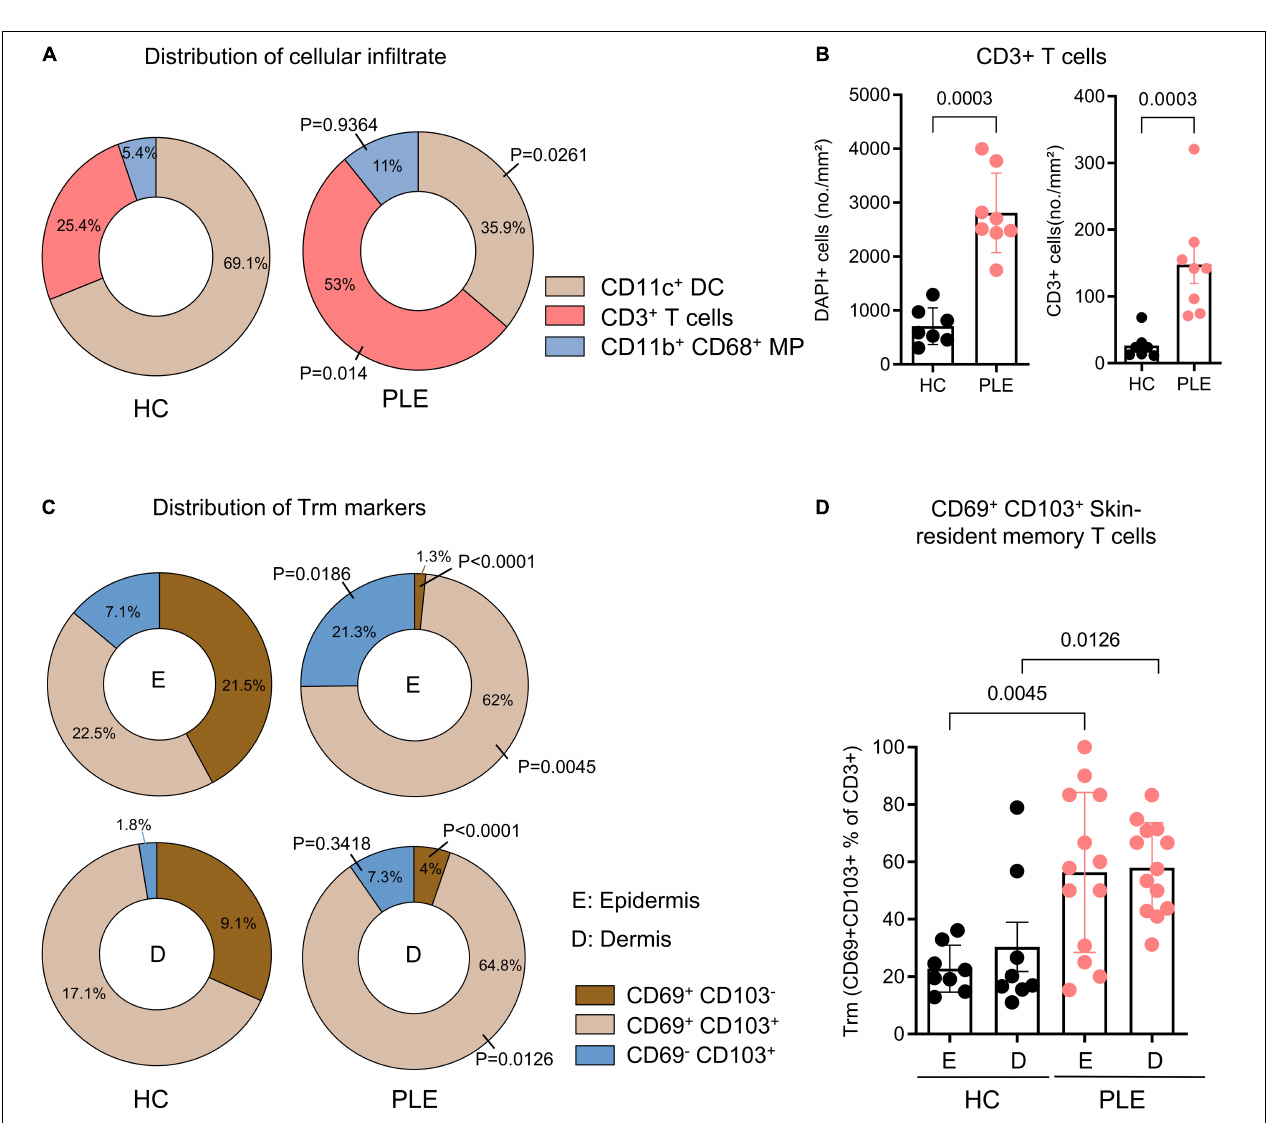
FIGURE 1 | Increased percentage of CD69 + CD103 + skin Trm cells in PLE lesions. (A) Relative distribution of CD11c + dendritic cell (DC), CD3 + T cells, and CD11b + CD68 + macrophages (MP) in healthy control (HC) and polymorphic light eruption (PLE), number shown as mean percentage of all categorized cells. Statistical analysis with Mann–Whitney test (B) Number of DAPI + cells and CD3 + T cells in healthy control (HC) and polymorphic light eruption (PLE) skin. Data shown as a mean cell number/mm 2 ± SD (HC: n = 7, PLE: n = 8). (C) Distribution of cells positive for Trm surface markers on CD3 + T cells of the epidermis (E) and dermis (D) from immunostaining data. Data are shown as a relative mean percentage of all samples in the pie charts. (D) Tissue residency marker-expressing T cells in PLE and healthy control skin; data shown as a percentage of CD69 + and CD103 + T cells among total CD3 + T cells ± SD. Statistical analysis with Mann-Whitney test, P values for PLE vs HC are indicated on the graphs (HC: n = 8, PLE: n =